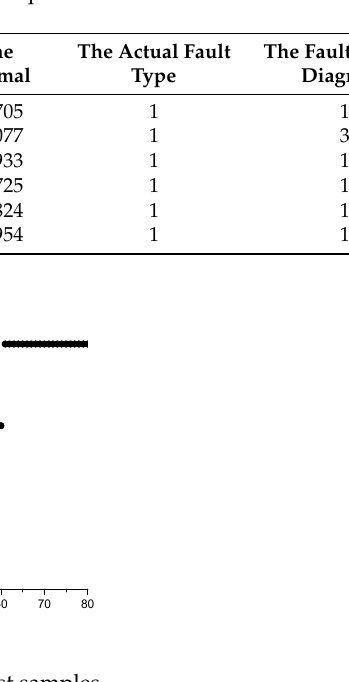
( b ) Figure 6. The experimental platform. ( a ) The experimental photovoltaic system; ( b ) The experimental instrument. DC: Direct Current. In the fault diagnosis model, the fault of abnormal aging is simulated by connecting a series resistor, while the fault of short circuit is simulated by paralleling a photovoltaic module with a constructor, disconnecting the constructor between two photovoltaic modules that represent the fault of open circuit. Four instances are implemented and studied, including in the states of normal, short circuit, open circuit, and abnormal aging. 80 sample groups in each state (320 sample groups altogether) were obtained, of which 60 sample groups were used as the training set, and the